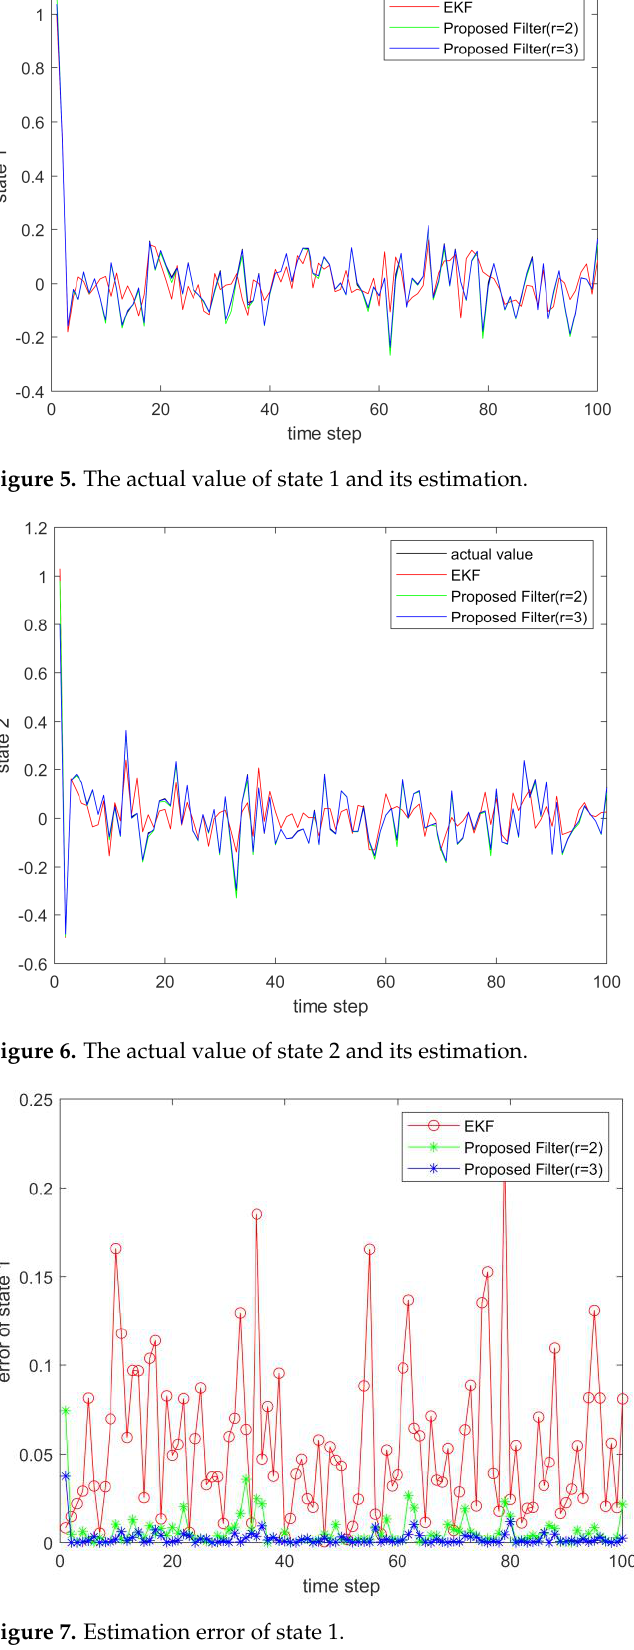
Figure 7. Estimation error of state 1.